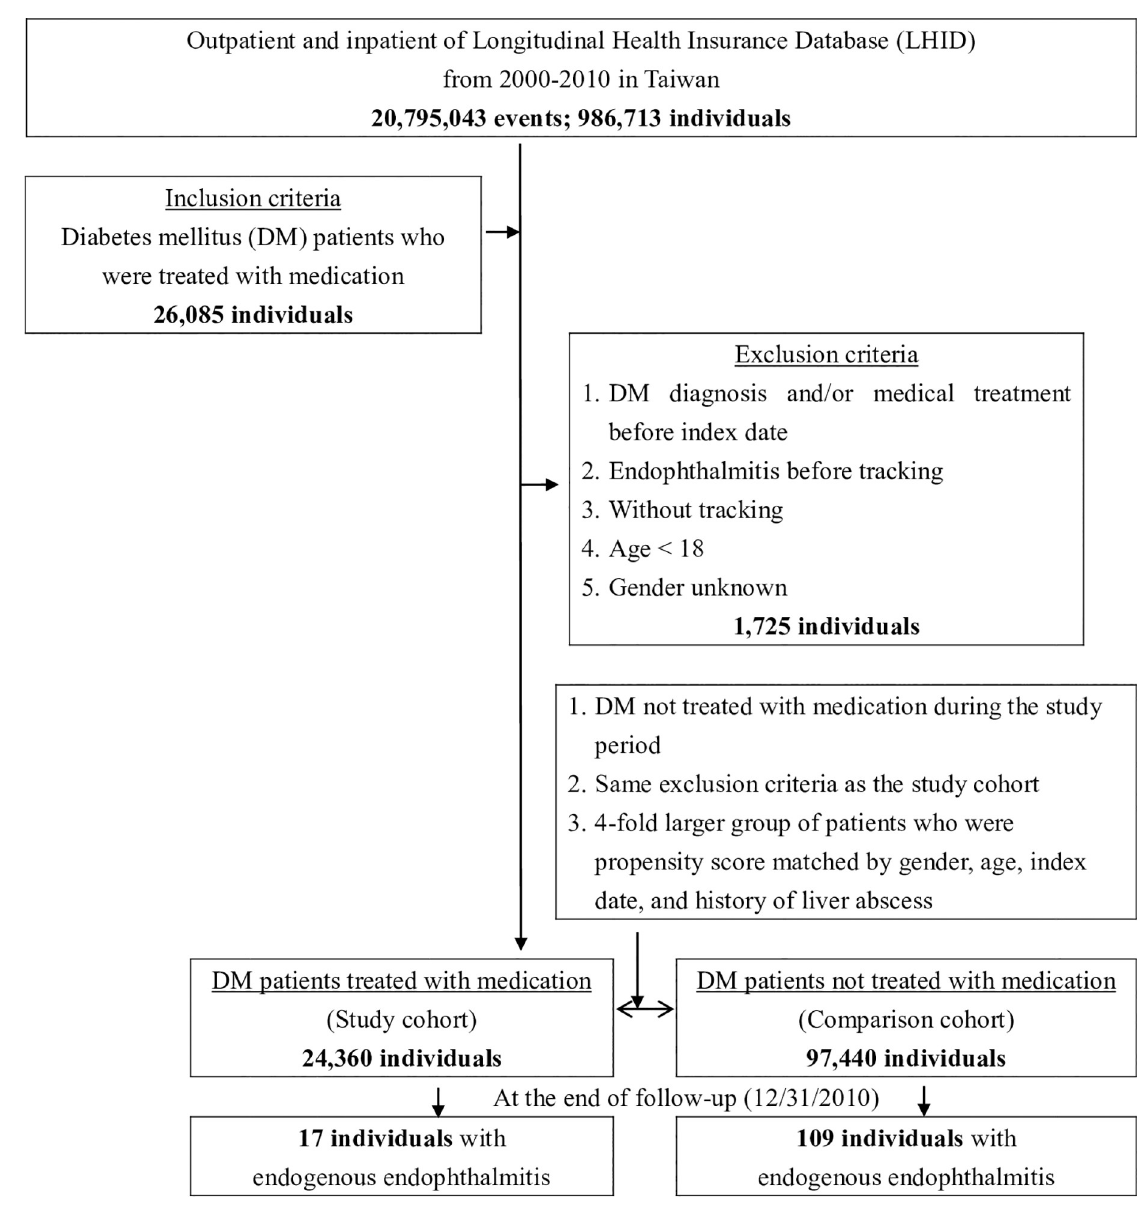
Fig 1. Flowchart of study sample selection from the National Health Insurance Research Database in